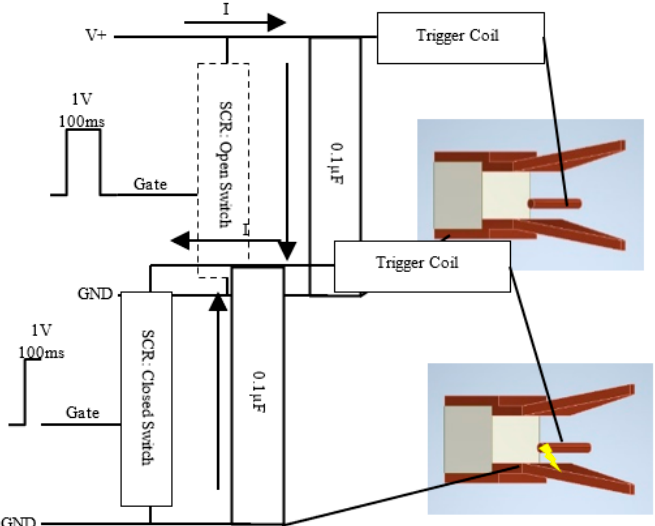
Figure 8. Firing Cycle of the Spark